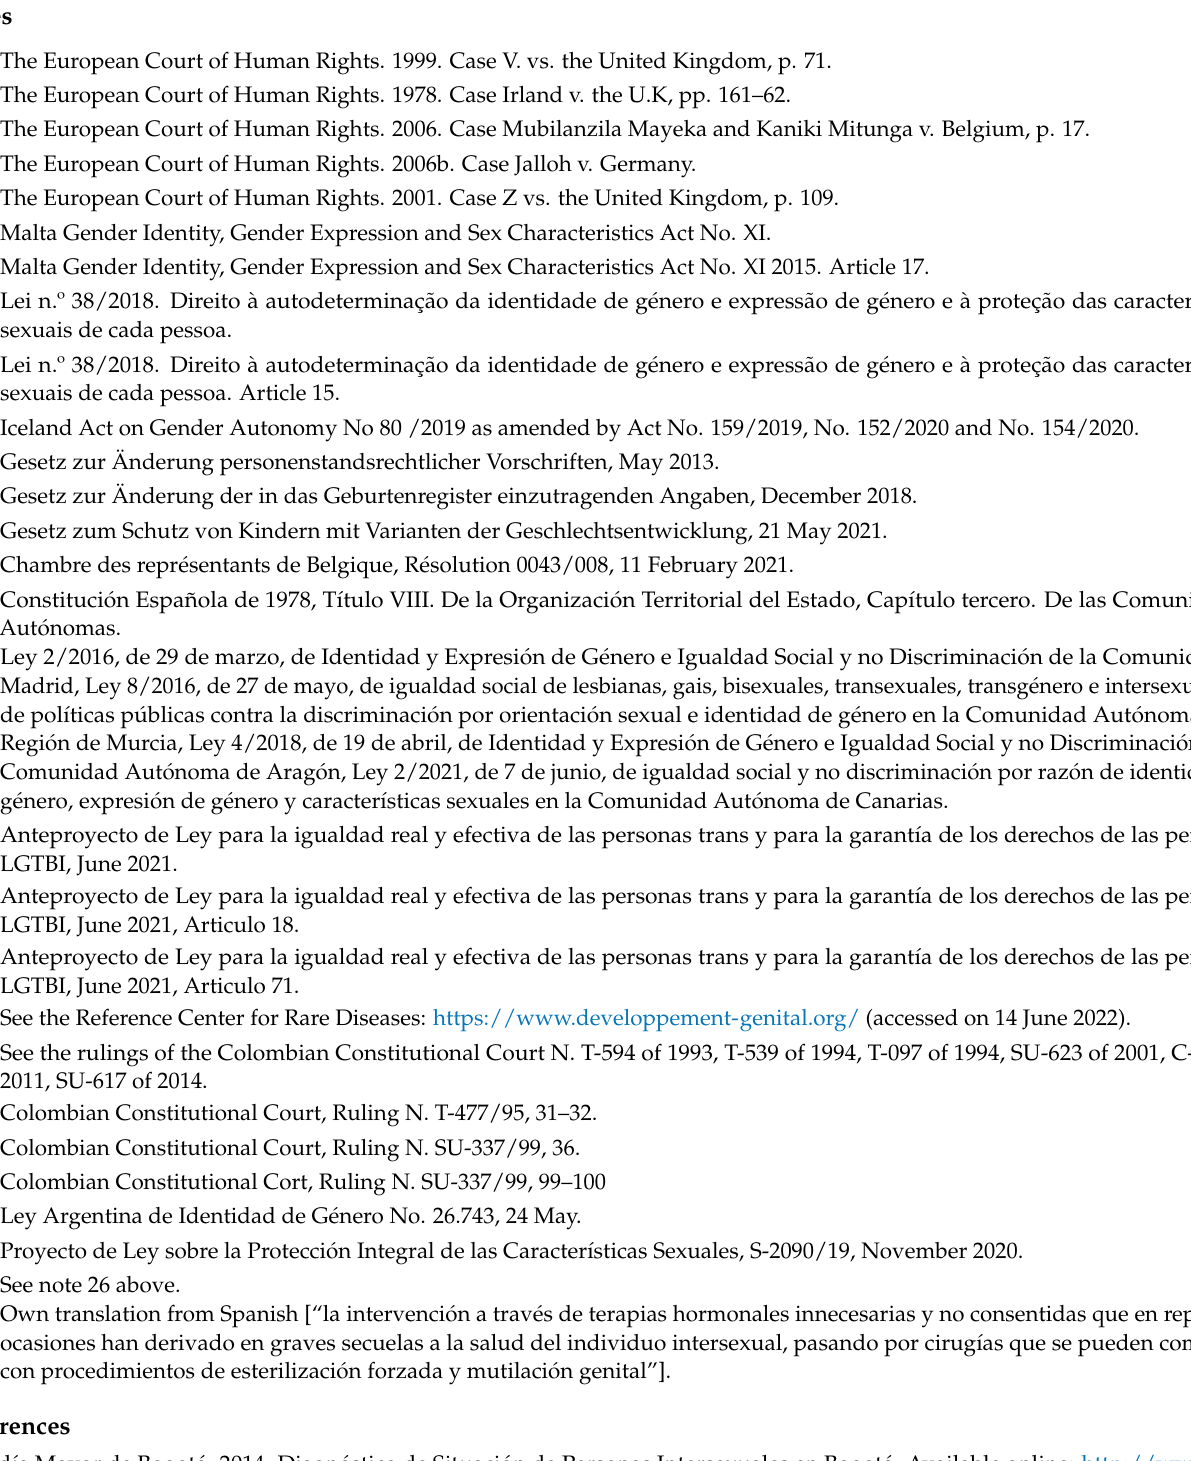
The European Court of Human Rights. 2001. Case Z vs. the United Kingdom, p. 109. Malta Gender Identity, Gender Expression and Sex Characteristics Act No. XI 2015. Article 17. 8 Lei n.º 38/2018. Direito à autodeterminaç ã o da identidade de g é nero e express ã o de g é nero e à proteç ã o das caracter í sticas sexuais de cada pessoa. 9 Lei n.º 38/2018. Direito à autodeterminaç ã o da identidade de g é nero e express ã o de g é nero e à proteç ã o das caracter í sticas sexuais de cada pessoa. Article